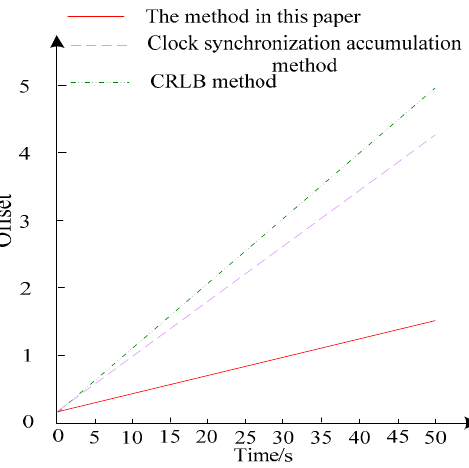
Figure 8. Clock drift diagram of unknown nodes.